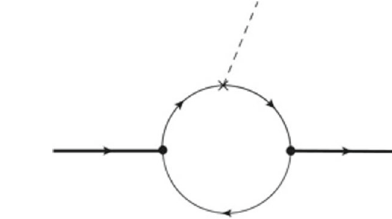
Fig. 1 The Feynman diagram for the matrix element within the CLF QM